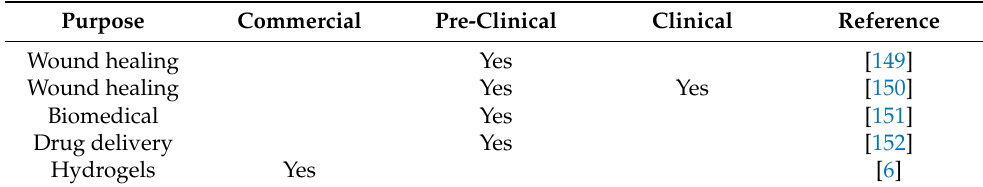
Table 2. Commercial-, preclinical-, and clinical-stage